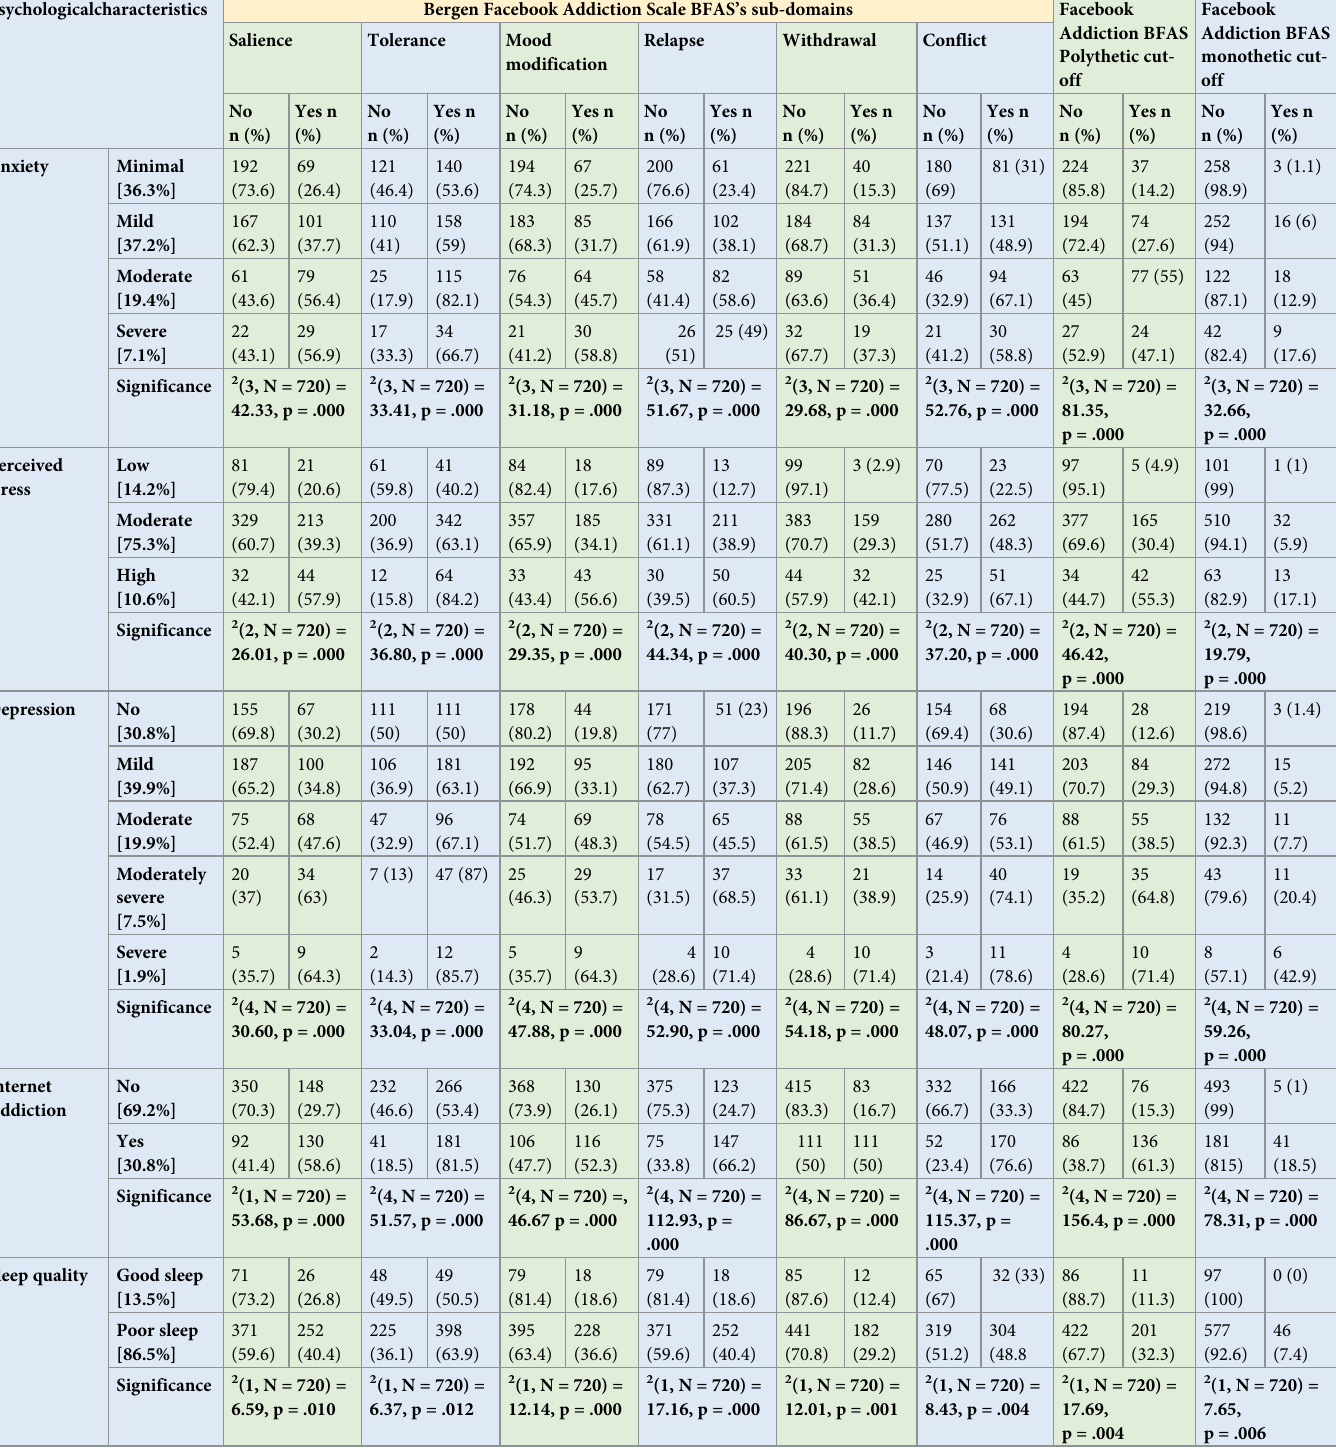
Table 4. Psychological and behavioral characteristics and Facebook addiction (N =